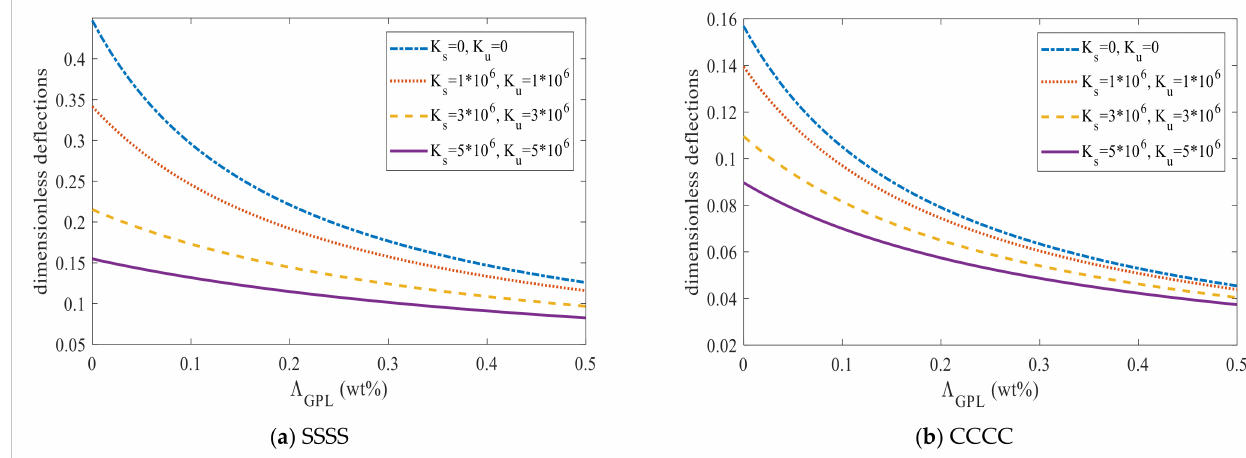
Figure 15. Dimensionless deflection vs. GPL weight fraction, for different Kerr foundation coefficients ( b / a = 1, (cid:1) a / h = 10, GPL − X , p 0 = 10 5 and K I = 10 5 : ( a ) SSSS boundary conditions, ( b ) CCCC boundary